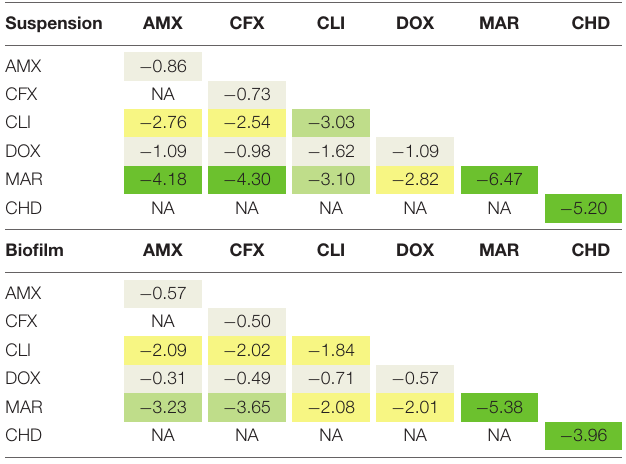
TABLE 3 | Bacterial reductions of S. pseudintermedius suspension (in